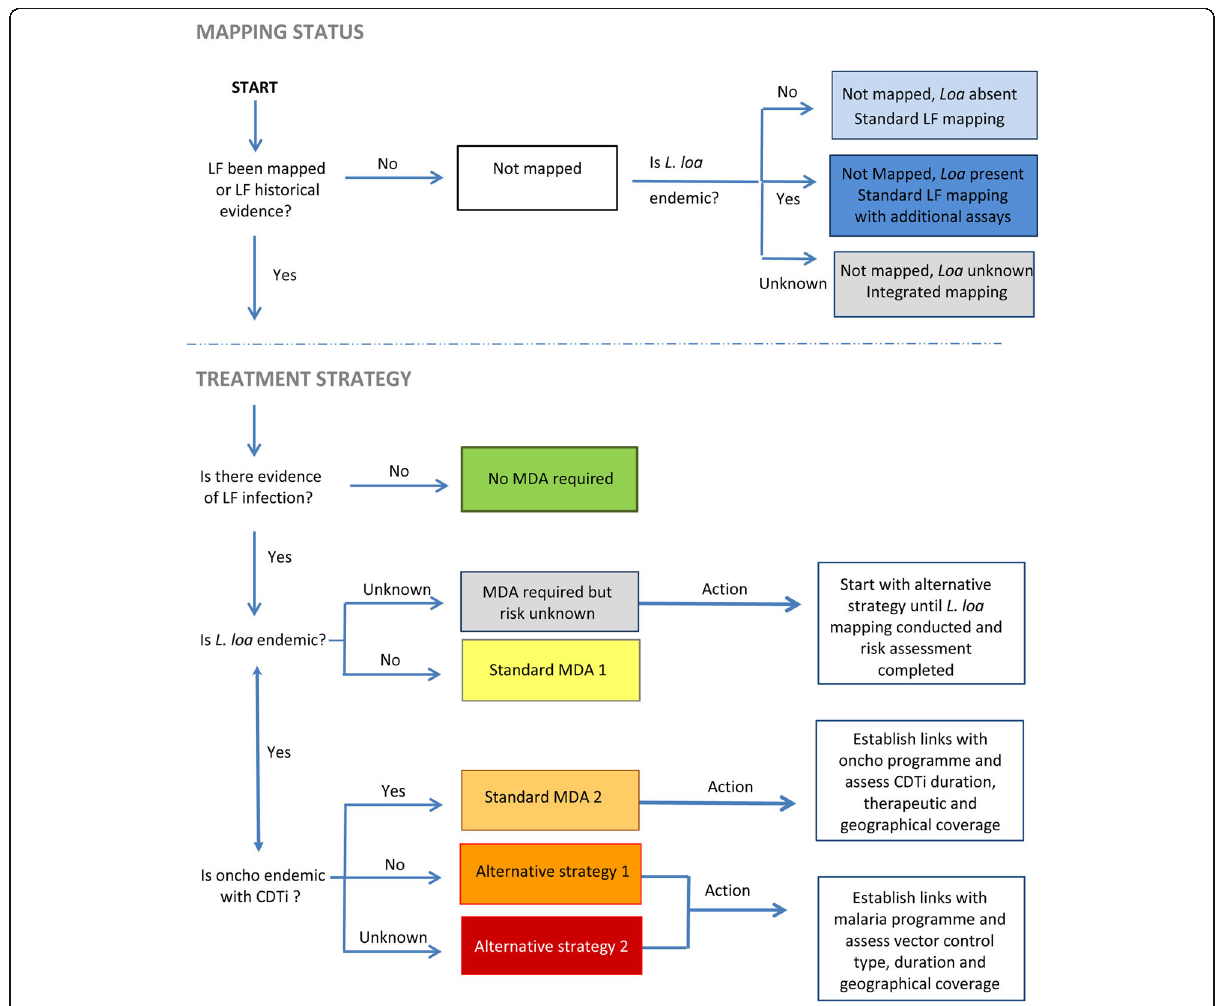
Fig. 2 Decision tree to determine the mapping and/or treatment strategy